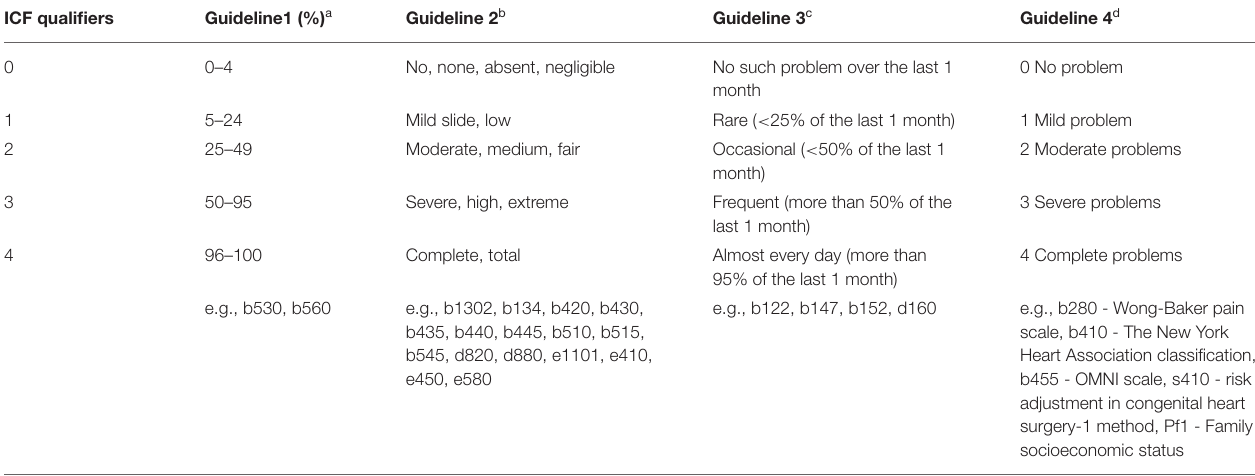
TABLE 1 | Measuring guidelines for the ICF-CY-CHDS.